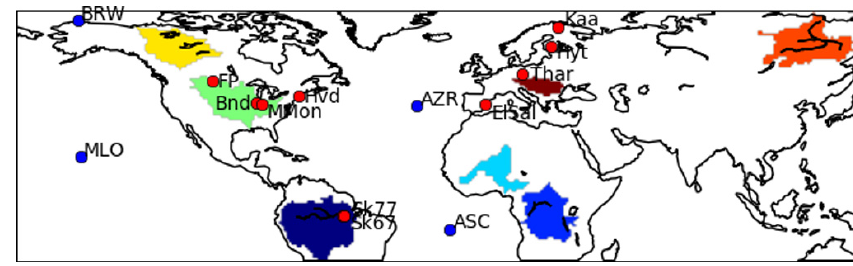
Fig. 1a. Map of FLUXNET stations, CO 2 stations and River basins.